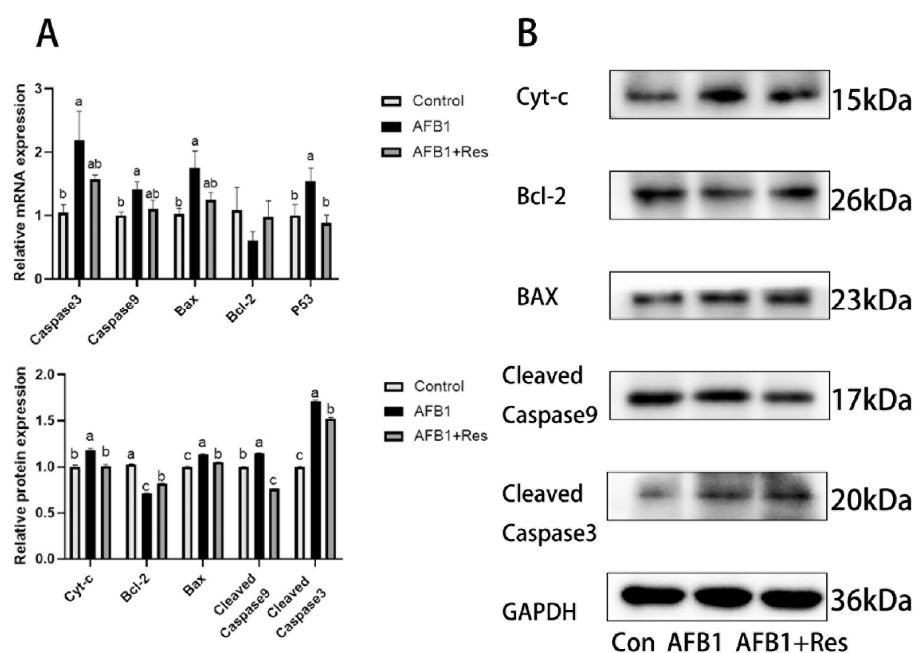
Figure 9. Effect of Res on the expression level of apoptosis-related genes in duck liver exposed to AFB1. Values are repre- sented as the mean ± SEM ( n = 6). a–c Mean values with same superscript letters or no letters within a row were of no significant difference ( p > 0.05), those with different superscript letters were of significant or extremely significant differ- ence ( p < 0.05). ( A ) mRNA levels of apoptosis-related genes. ( B ) protein levels of apoptosis-related genes